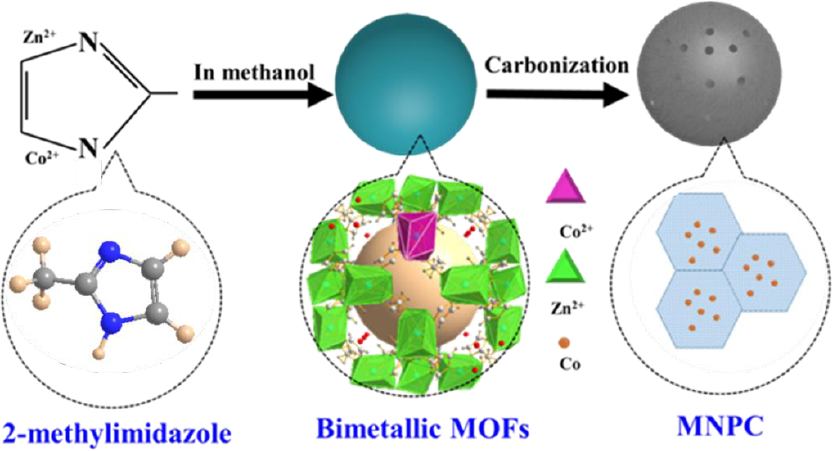
Figure 1. Schematic illustration of the construction process for the magnetic nitrogen-doped porous carbon (MNPC).